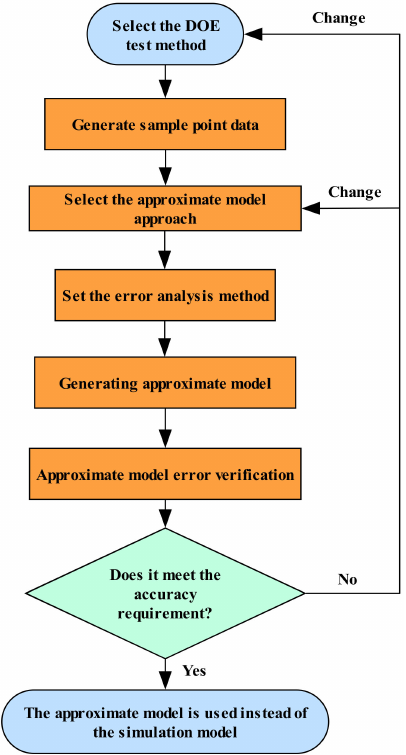
Figure 10. Process of building approximate model of aluminium alloy front